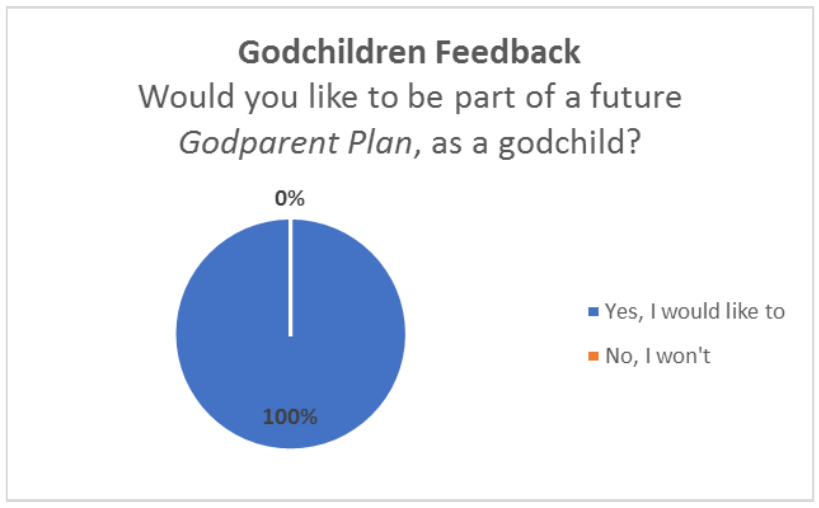
Fig. 6. Godchildren’ interest towards being godchildren in a future Godparent Plan